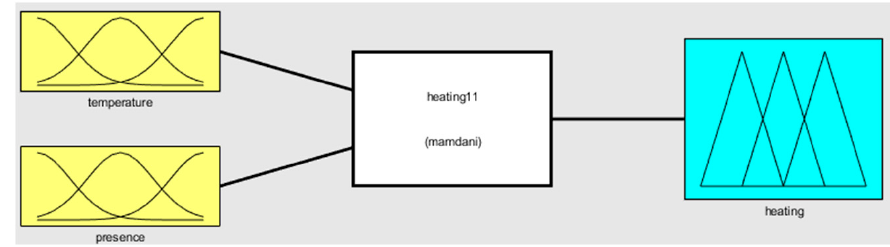
Figure 4. Fuzzy heating model.